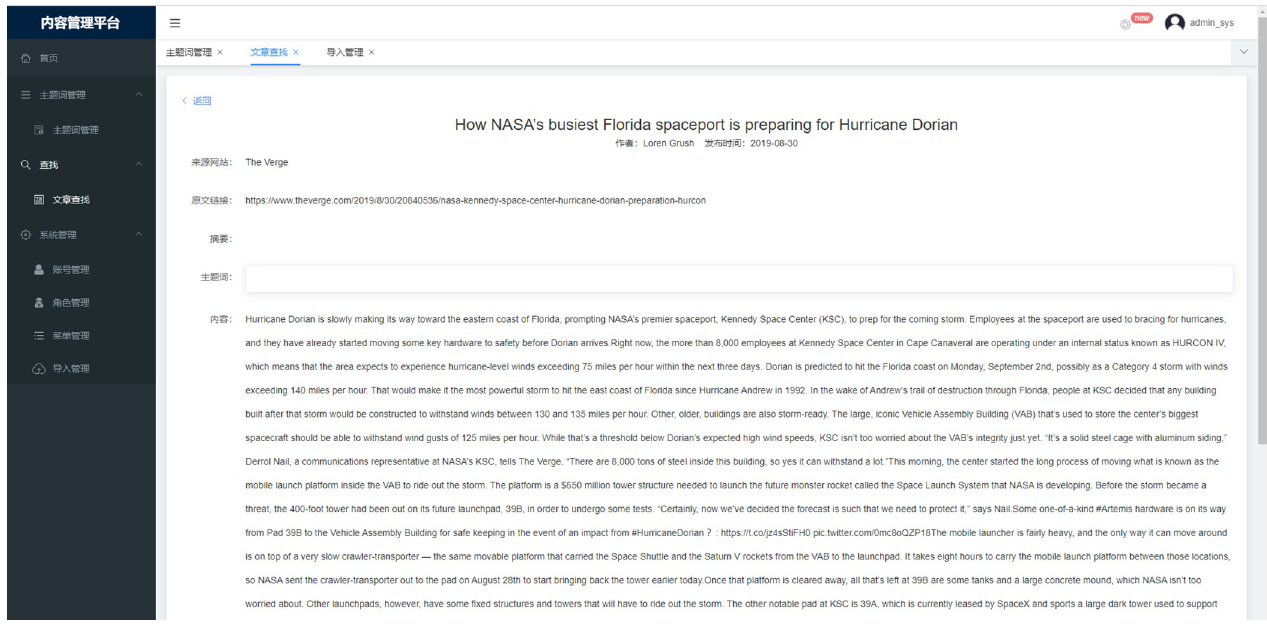
In March 2019, China’s Huawei proposed that 6G should include sea, land, air and even underwater spaces. Tsinghua University also proposed that electric and autonomous vehicles can be used as mobile cloud servers or base stations [57].